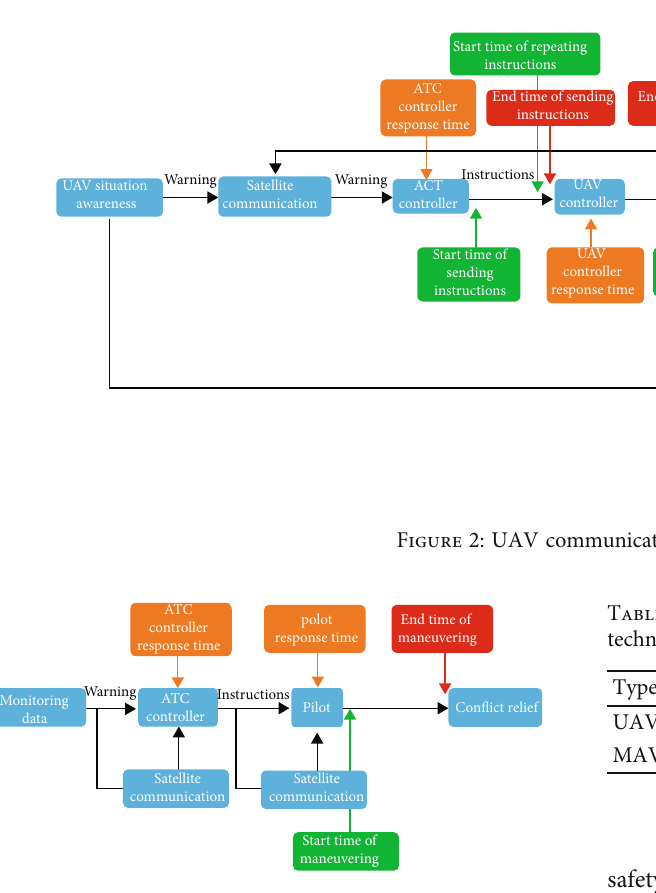
Figure 3: MAV communication lag-time.